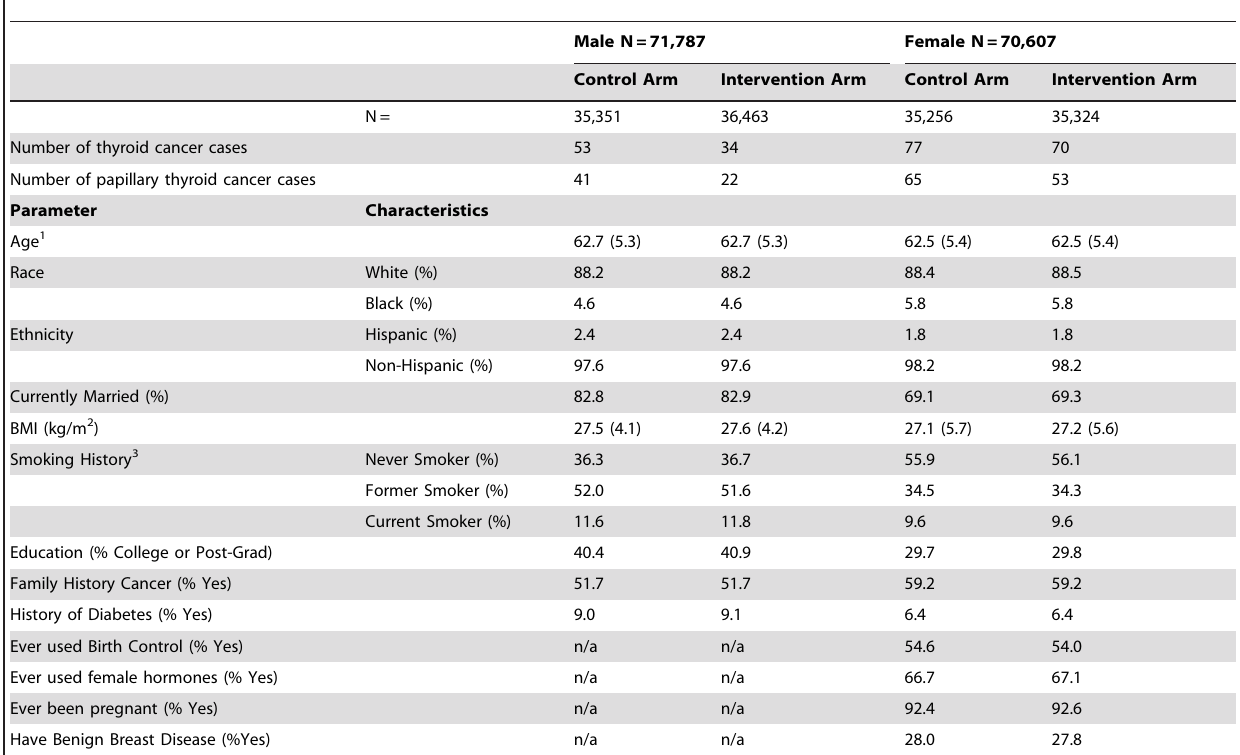
Table 2. Baseline characteristics of participants in the PLCO by randomization